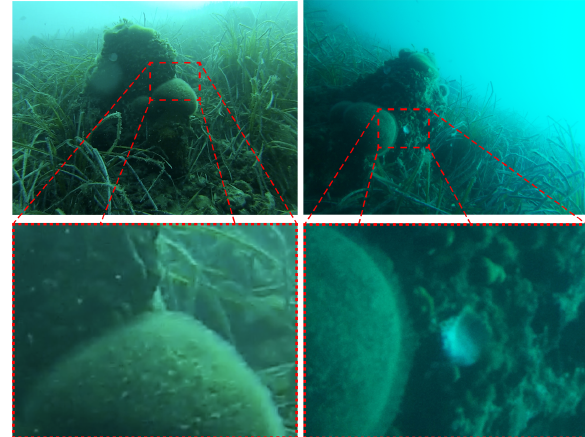
Figure 2. Visual comparison of the quality of the cameras: on the left an image taken by a GoPro with a zoom of a part in the lower right corner, and on the right an image taken at the same time by a PiCam, with a zoom of an equivalent portion of the image in the lower right